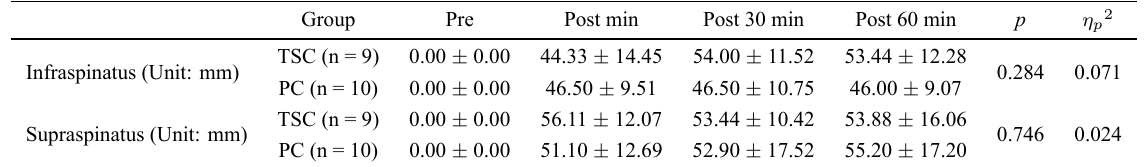
Table 3. Changes in muscle pain after topical sports cream.